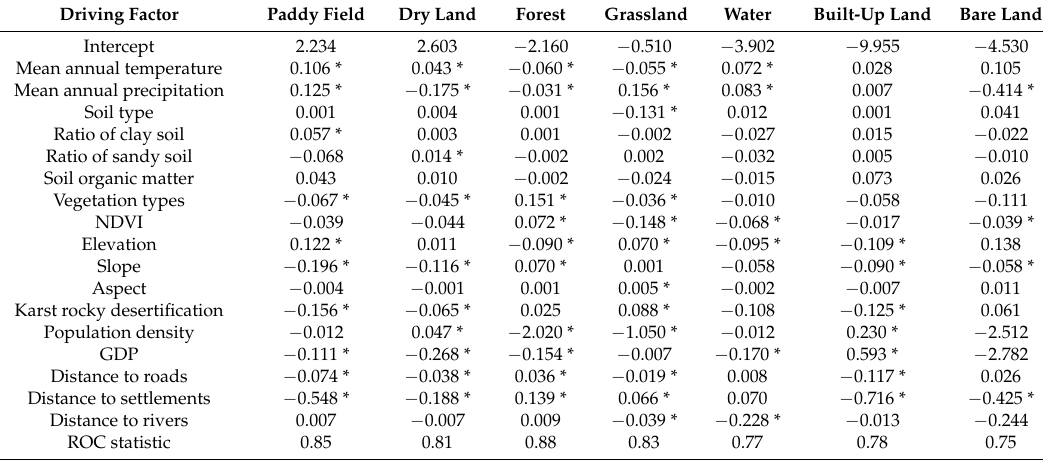
Table 5. Logistic regression model estimates for land use